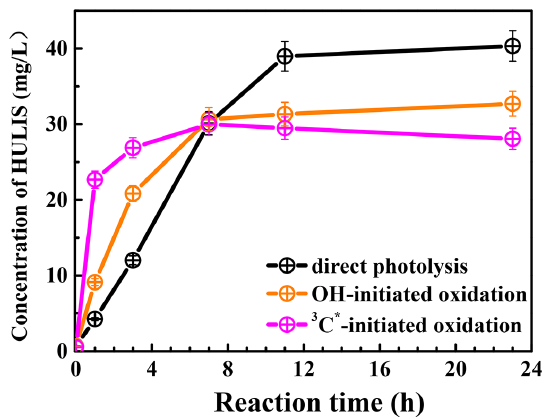
Figure 7. HULIS concentrations as a function of reaction time un- der direct photolysis, OH-initiated oxidation, and 3 C ∗ -initiated ox-